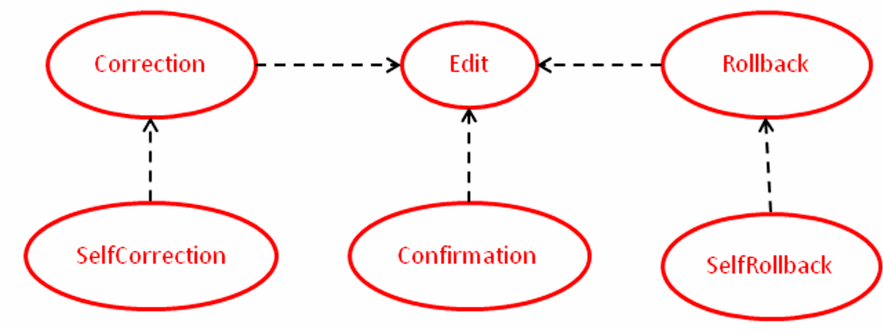
Figure 8. Patterns as subclasses of the Edit class (Source: [18]).